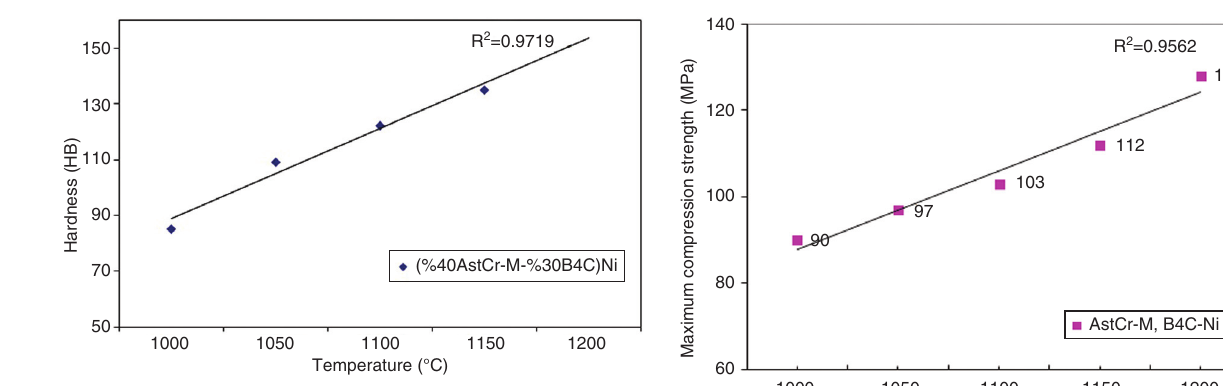
Figure 5 Hardness measurements results with respect to sintering temperatures.